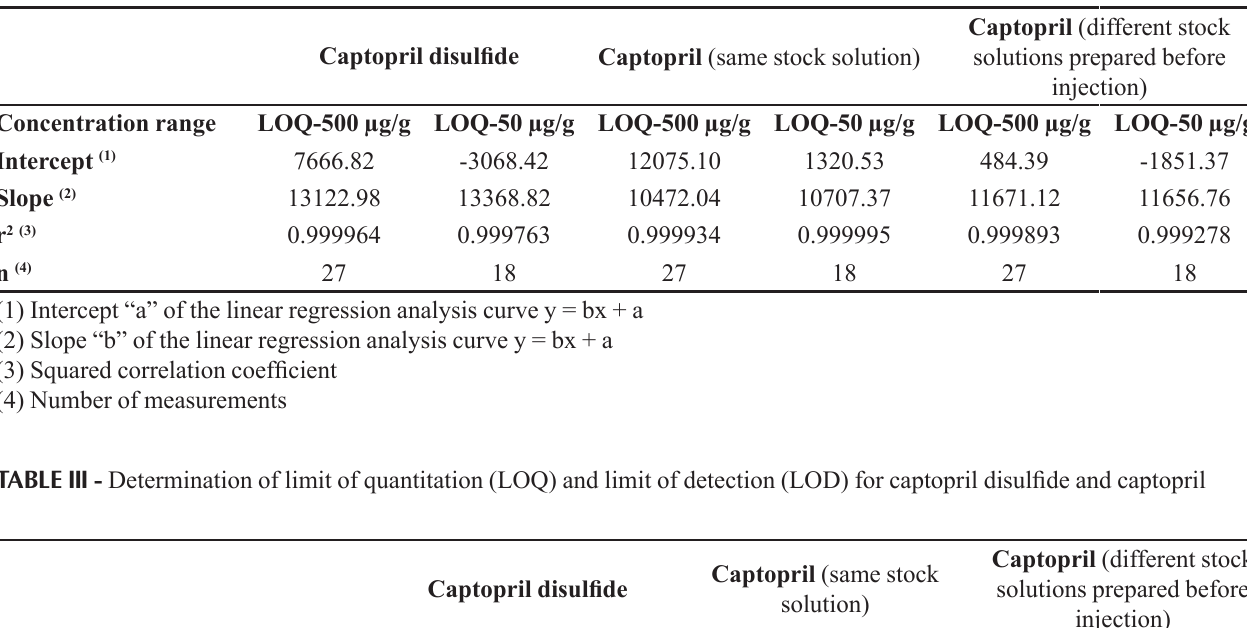
TABLE II - Linearity evaluation for captopril disulfide and captopril in two different concentration ranges (LOQ to 50 µg/g and LOQ to 500 µg/g)